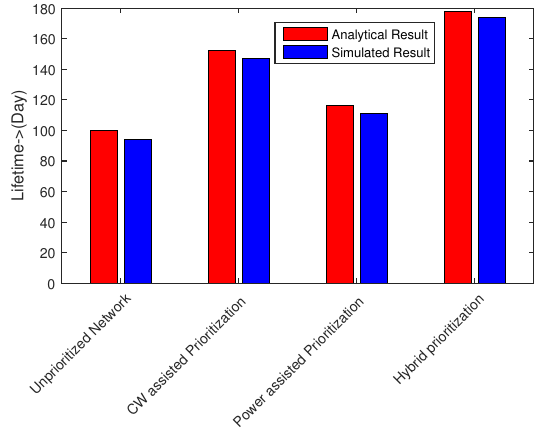
Figure 24. Network